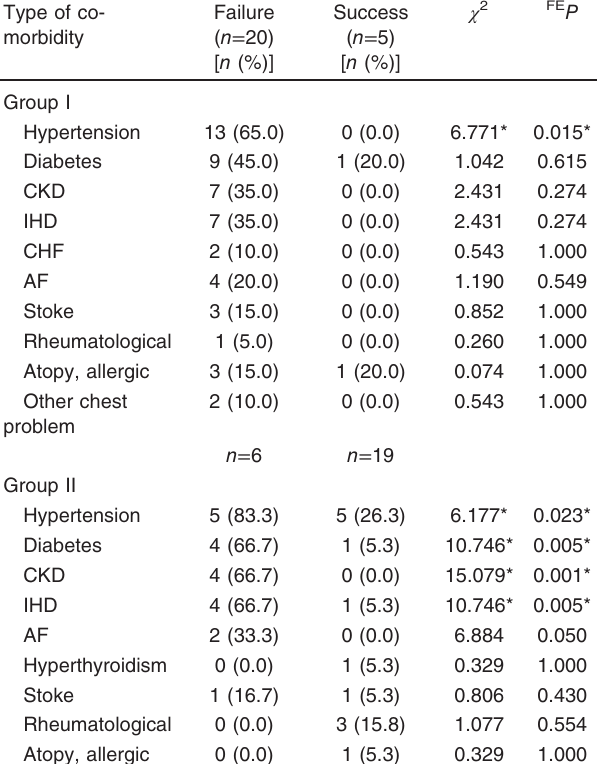
Table 7 Relation between the type of associated comorbidities and the outcome of cases in studied groups Type of co- morbidity